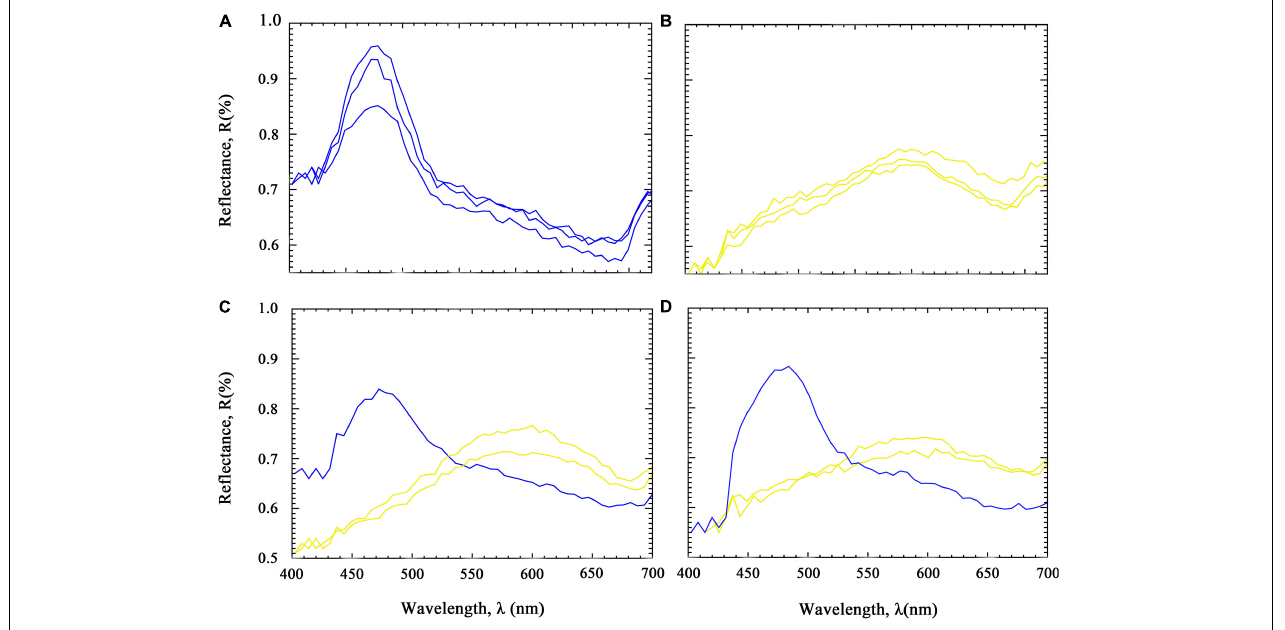
FIGURE 2 | Spectra from individual iridocytes from Tridacna crocea , corresponding to Figure 1 . (A) BB progeny. (B) YY progeny. (C) BY Progeny. (D) YB Progeny. Each line indicates a single iridocyte’s color with one main peak in the outer